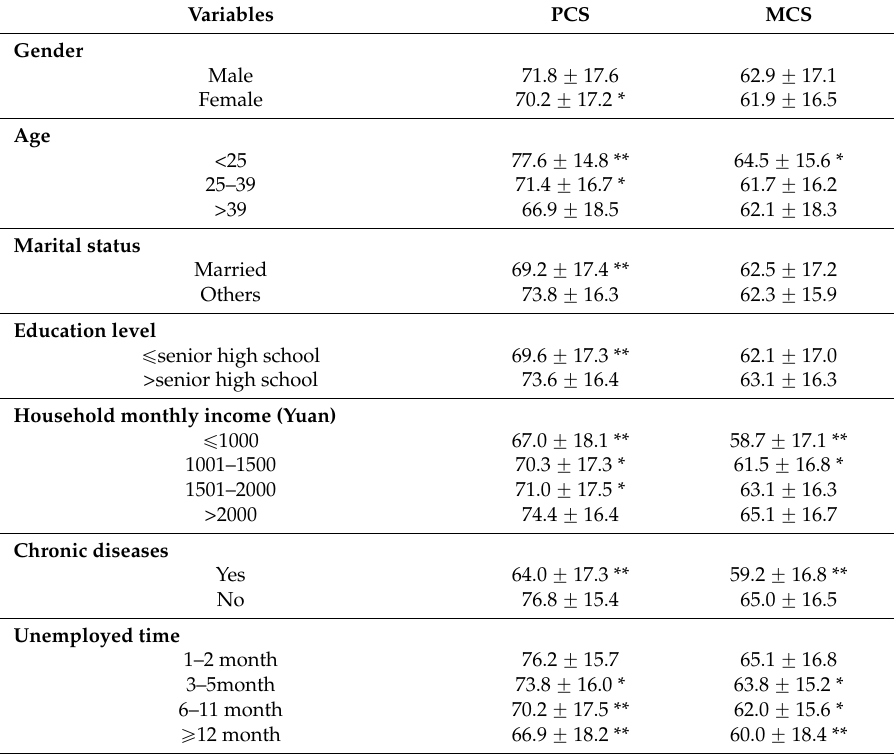
Table 2. QOL scores of unemployed people on demographic characteristics ( N =